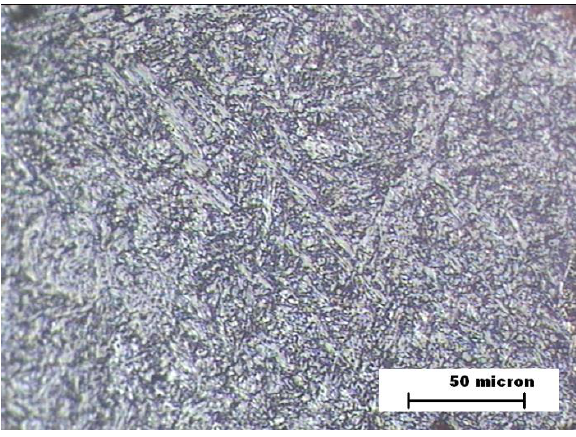
Figure 7. Sample B. FZ microstructure.